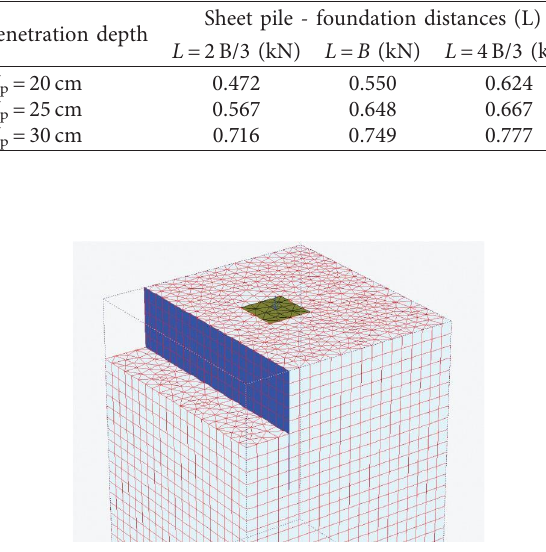
Figure 16: 3D mesh of excavation from the PLAXIS 3D foundation.